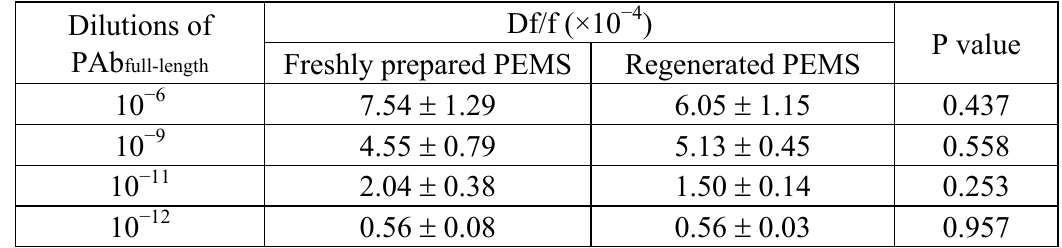
Table 1. Comparison between freshly prepared PEMS and regenerated